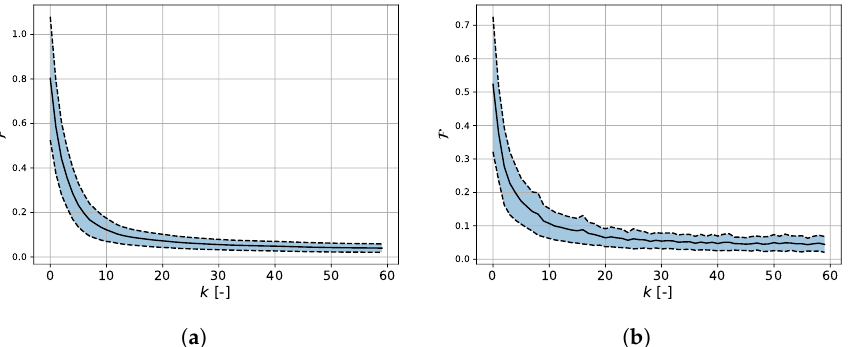
Figure 13. Mean and standard deviation calculated from 20 runs of optimization. ( a ) Single-criteria optimization; ( b ) Multi-criteria